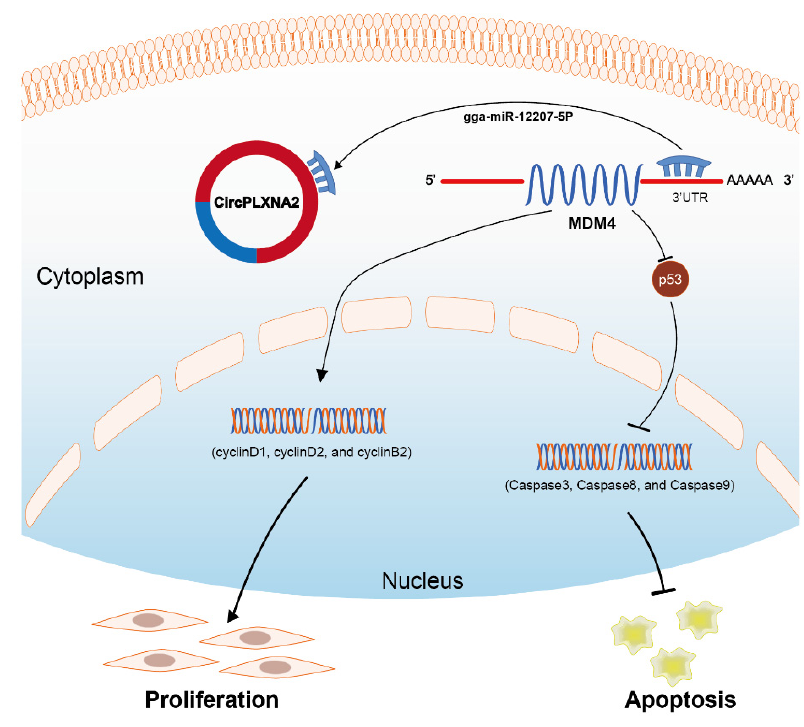
Figure 8. Schematic diagram of how CircPLXNA2 affected the proliferation and apoptosis of the myoblast circPLXNA2 /gga ‐ miR ‐ 12207 ‐ 5P/ MDM4 axis.